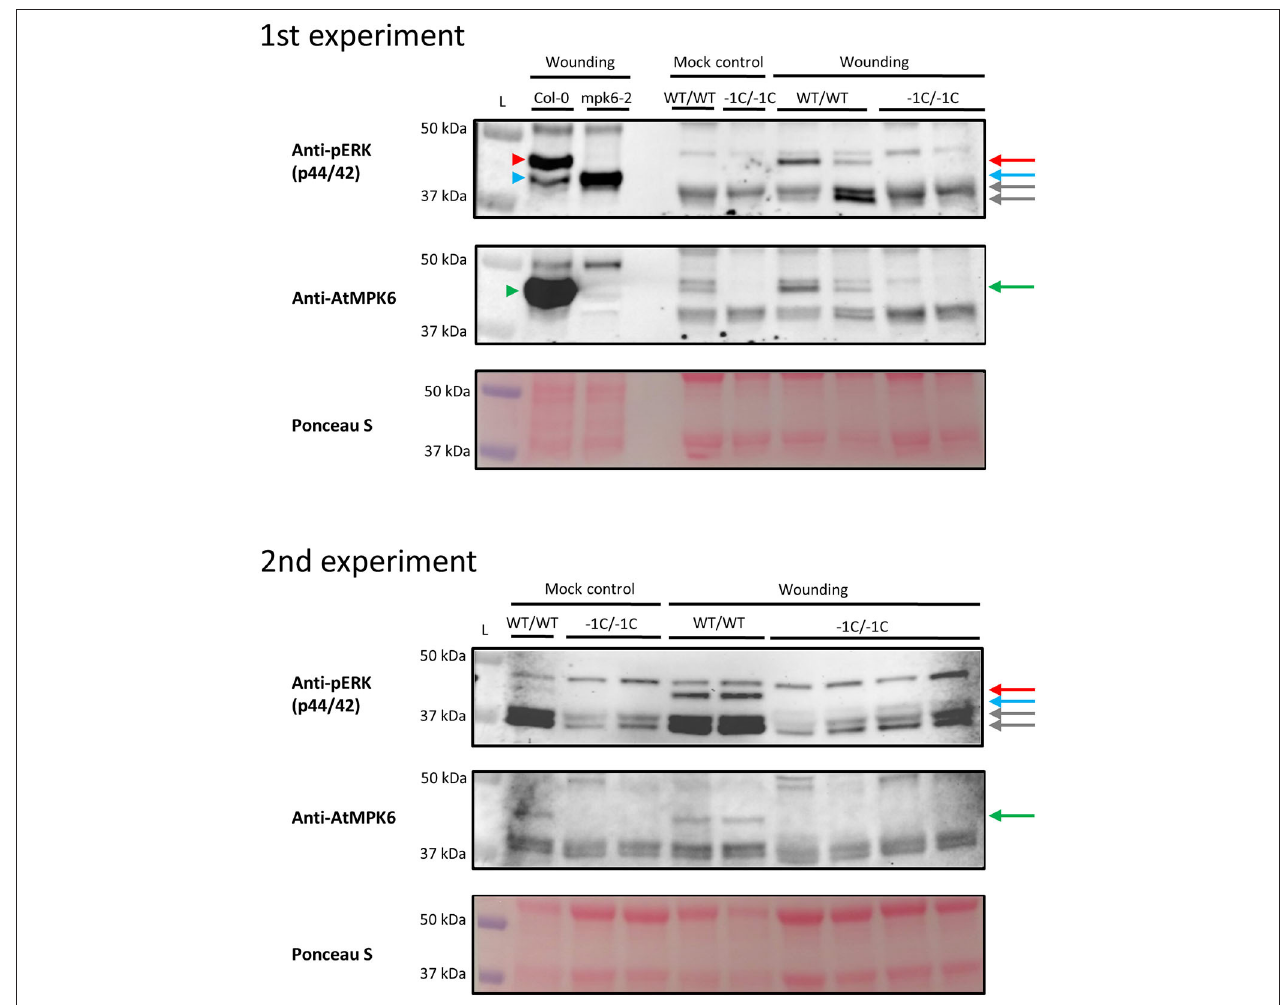
FIGURE 10 | Immunoblot detection of phosphorylated pHvMPK6 and HvMPK6 in the Hvmpk6 mutant ( − 1C/ − 1C) and WT (WT/WT) non-transgenic endosperms with bran and husk. Two representative independent experiments (first experiment and second experiment) are shown. The whole immunoblotted membranes were probed first with an anti-pERK 1/2 antibody and subsequently restriped with an anti-AtMPK6 antibody. For loading control, the whole blotted membranes were stained with Ponceau S. Selected area of the membranes is shown. Mature T3-generation grains of heterozygous mutant (WT/ − 1C) transgenic plants and mature grains of WT (WT/WT) non-transgenic control plants were imbibed in Milli-Q water at 21 ◦ C in darkness for 24h before embryo extirpation and subsequent analysis. Following embryo extirpation, endosperms with bran and husk were immediately frozen [basal phosphorylation of mitogen-activated protein kinases (MAPKs), mock control] or immediately squeezed and incubated at room temperature for 15min before freezing (phosphorylated MAPKs, wounding). − 1C/ − 1C endosperms with bran and husk were identified based on the abnormal phenotype of the respective extirpated embryos and subsequent PCR-based genotyping of these embryos. Samples from in vitro grown wounded seedlings of Arabidopsis Col-0 ecotype (Col-0) and mpk6-2 mutant ( mpk6-2 ) were used as references. The red arrowhead indicates the phosphorylated Arabidopsis pMPK6 (anti-pERK 1/2) that is present in Col-0 but missing in mpk6-2, and the green arrowhead indicates Arabidopsis MPK6 (anti-AtMPK6), which is present in Col-0 but missing in mpk6-2 . Light blue arrowhead indicates another phosphorylated Arabidopsis pMPK (anti-pERK 1/2), most probably pMPK3, as it is more abundant in mpk6-2 than in Col-0 possibly to partially compensate for the absence of MPK6 (Genenncher et al., 2016). The red arrow indicates phosphorylated barley pHvMPK6 (anti-pERK 1/2), which is present in WT/WT but missing in the − 1C/ − 1C endosperms with bran and husk and the green arrow indicates barley HvMPK6 (anti-AtMPK6), which is present in WT/WT but missing in the − 1C/ − 1C endosperms with bran and husk. The light blue arrow indicates another phosphorylated barley pMPK (anti-pERK 1/2), possibly barley pMPK3 (pHvMPK3), as it is detected only in wound treated − 1C/ − 1C endosperms with bran and husk but missing in the mock-treated mutant − 1C/ − 1C endosperms with bran and husk. Similar to Arabidopsis pMPK3, a higher phosphorylation level of pHvMPK3 may partially compensate for the absence of HvMPK6. The gray arrows indicate two unknown proteins (anti-pERK1/2), which are highly phosphorylated and/or abundant in WT/WT endosperms with bran and husk irrespectively of the treatment conditions (mock and wounding) but reduced or missing in − 1C/ − 1C endosperms with bran and husk. L-Precision Plus Protein TM Dual Color Standards (#1610374, BioRad, Hercules, CA, USA). Sizes of the selected ladder fragments are shown on the left of the membranes. Full scans of the whole immunoblotting membranes are shown in Supplementary Figures 11, 12 .